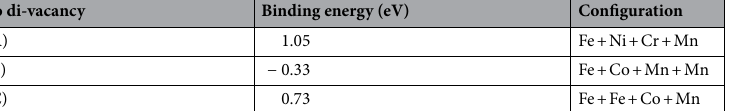
Two di-vacancy Binding energy (eV)